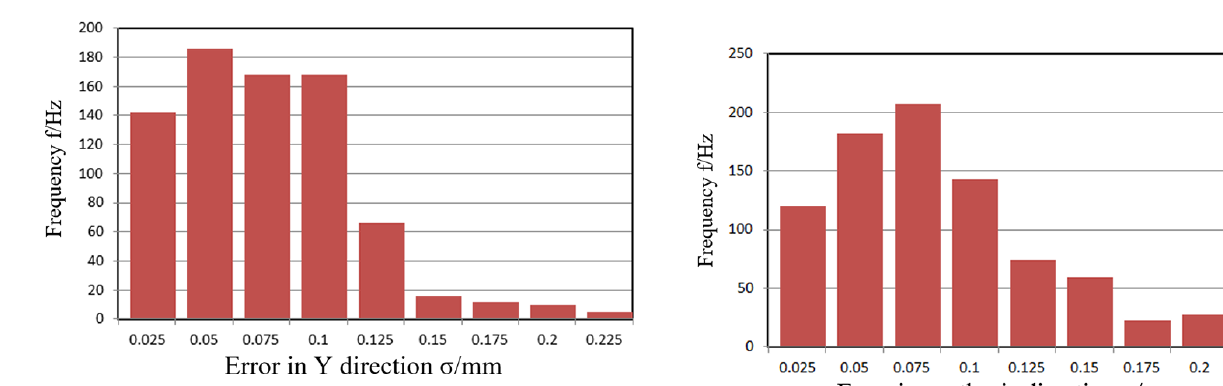
Figure 9. Frequency histogram of position error on working point in (0, 100, 1000) by error independent method.